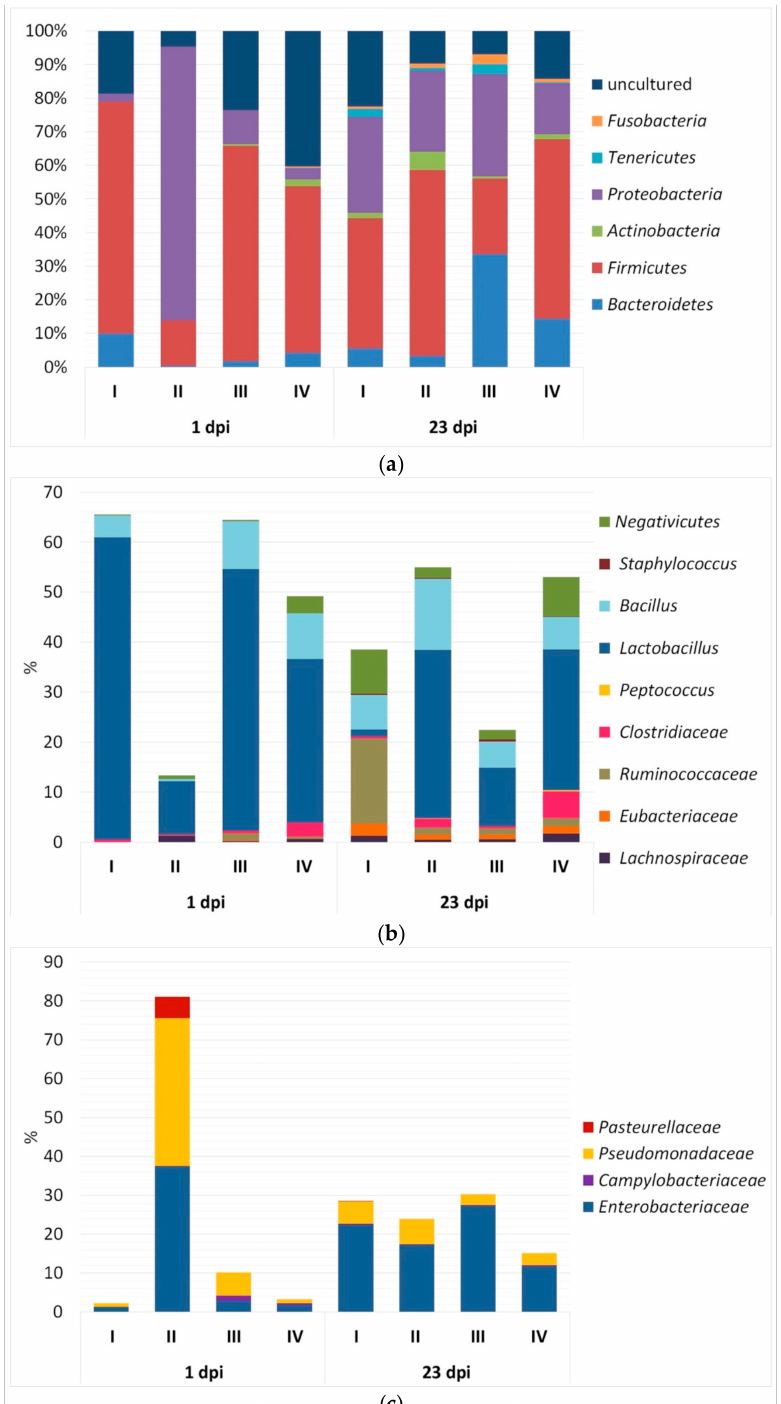
Figure 3. Composition of the microbiota in the chicken caecum ( n = 3) using the T-RFLP method: ( a ) representation of the phyla and unidentified bacteria, ( b ) taxa of the phylum Firmicutes , ( c ) taxa of the phylum Proteobacteria . Subgroups: I, negative control not challenged and fed normal diet; II, control with SE infection; III, Intebio administration; IV, Intebio administration with SE